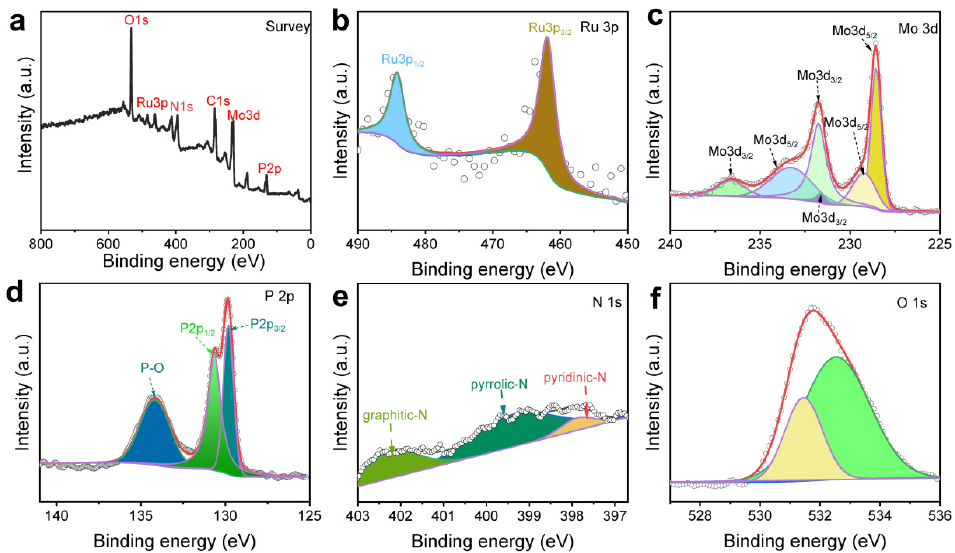
Figure 2. ( a ) The survey spectra for the MoP-RuP 2 @NPC. High-resolution XPS spectra of Ru 3p ( b ), Mo 3d ( c ), P 2p ( d ), N 1s ( e ) and O 1s ( f ) of the MoP-RuP 2 @NPC